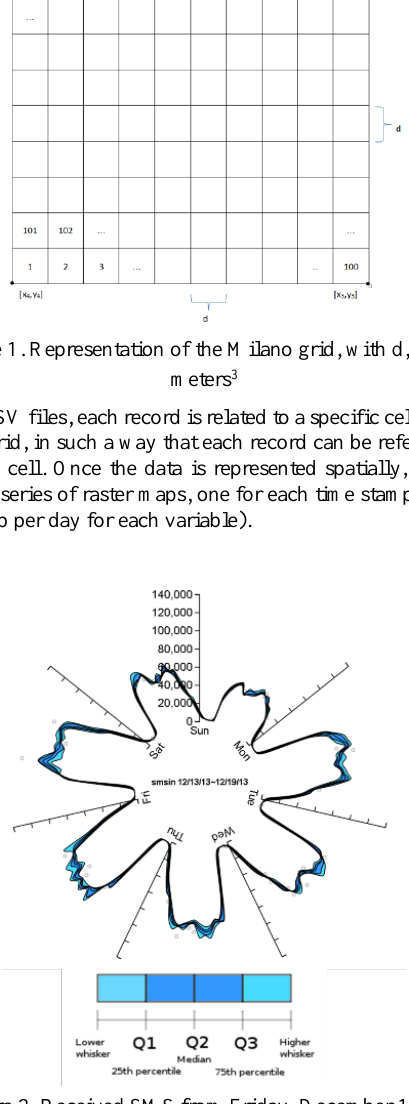
Figure 2. Received SMS from Friday, December 13 th to Thursday, December 19 th for all Milano grid cells Figure 2 evidences a strong daily seasonality of receive SMS corresponding with working and non-working hours; the same behavior is observed for the rest of the variables (Calls, Internet connections, tweets) indicating a temporal human behavioral pattern. Likewise, there is a weekly seasonality between working days and weekends, with Sunday the day with less